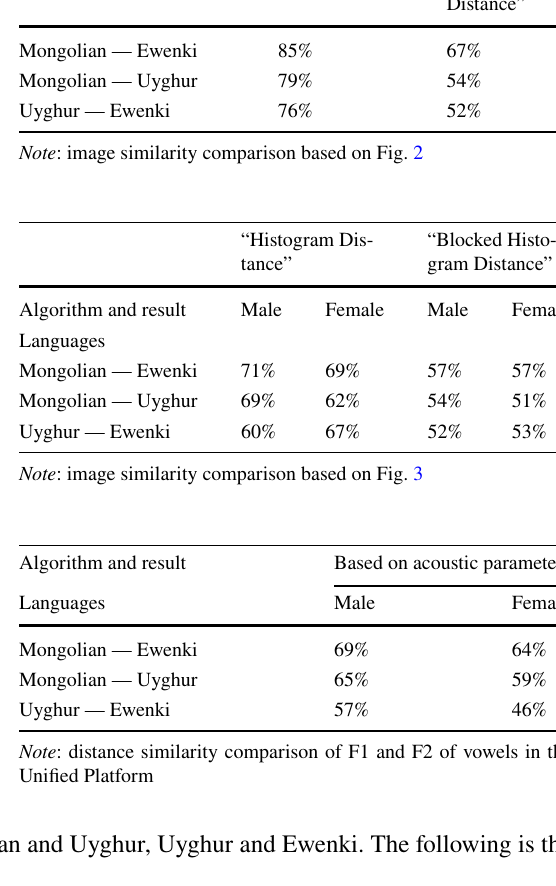
Table 1 Comparison of acoustic distribution patterns of vowels in three languages (actual)